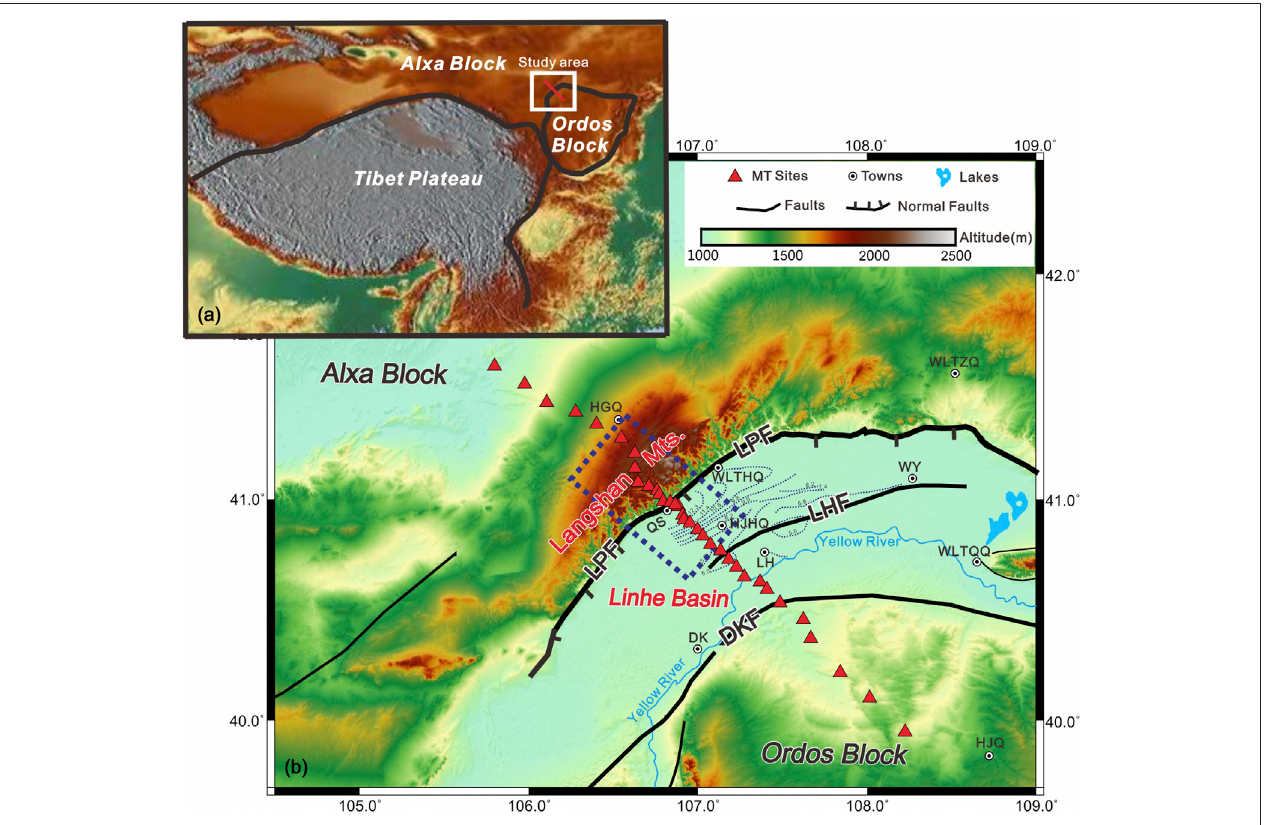
FIGURE 1 | Regional tectonic setting (A) distribution map of faults and magnetotelluric (MT) sites on the northwest edge of Ordos Block (B) The thickness of the Cenozoic sedimentary layer is quoted from the State Seismological Bureau (1988). LPF, Langshan Piedmont fault; LHF, Linhe fault; DKF, Dengkou fault; QS, Qingshan; HJHQ, Hangjinhouqi; LH, Linhe; DK, Dengkou; WH, Wuhai; WLTHQ, Wulatehouqi; WY, Wuyuan; WLTQQ, Wulateqianqi; WLTZQ, Wulatezhongqi; HJQ, Hangjinqi.